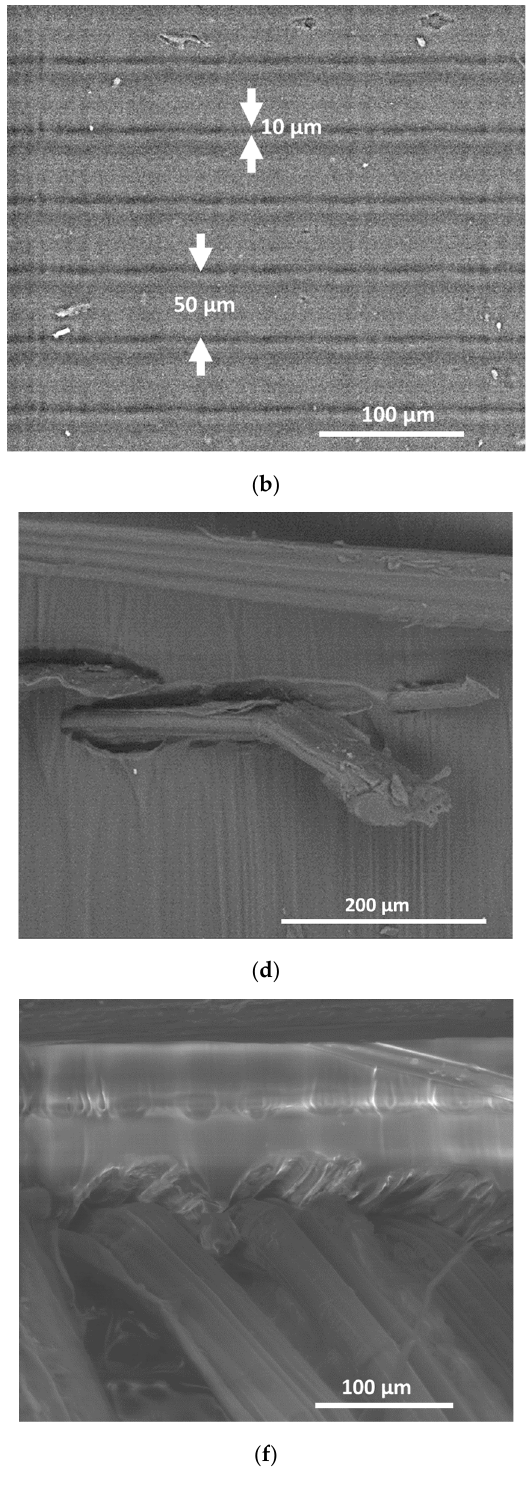
Figure 10. SEM micrographs of 3D-printed composites: ( a ) Cross-section view of 3D-printed resin with arrows showing the printing direction, ( b ) the same view with arrows embedded in the micro- graph showing the necking and layer height, ( c , d ) Cross section views of the composite with hemp fiber reinforcement, ( e , f ) Views from the edge of the same composite under different magnifications.